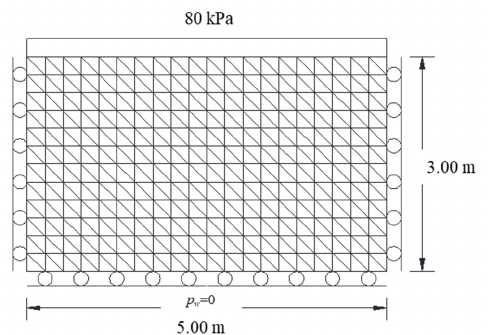
Figure 1. Soil domain under study with triangular linear finite element meshing. Table 1. Properties of the saturated soil for mechanical analysis of the foundation.